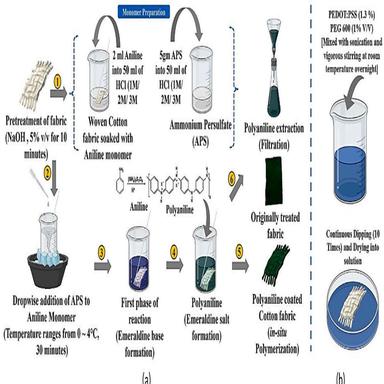
Chronological process flow of (a) PANI (b) PEDOT: PSS incorporated cotton fabric preparation.